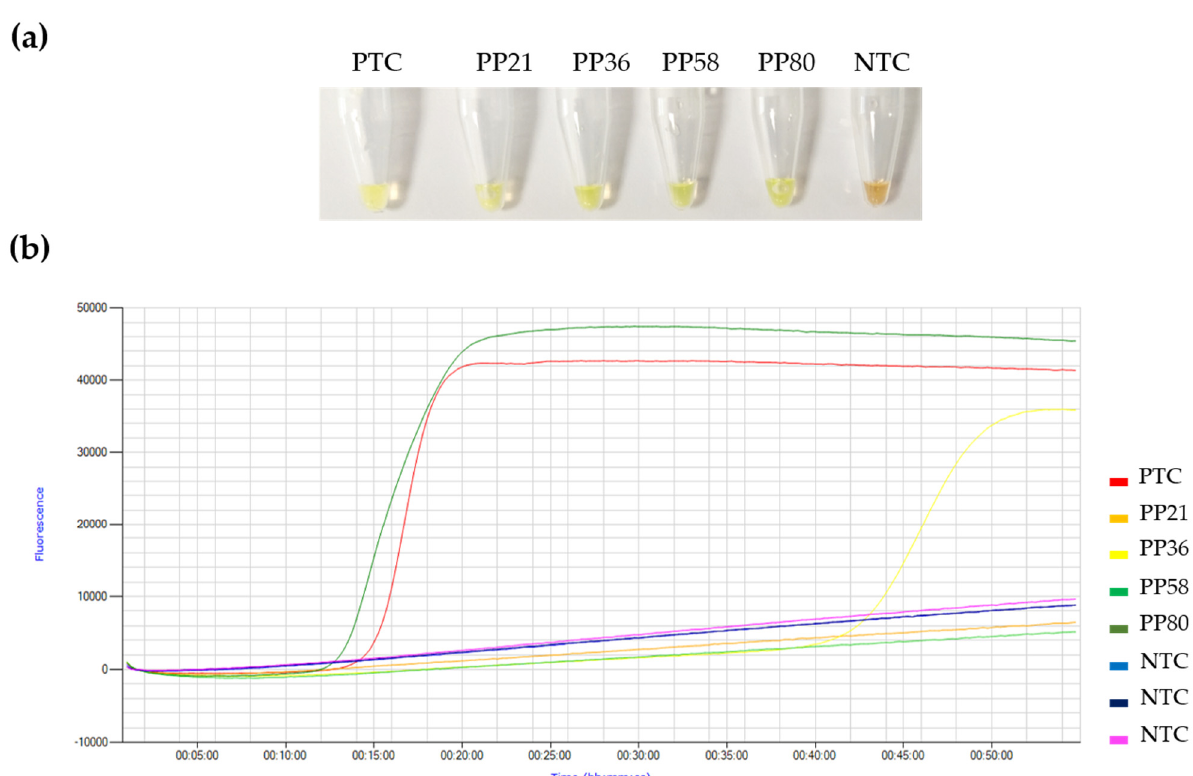
Figure 2. Detection of SARS-CoV-2 RNA in urine samples by colorimetric and real-time N15-RT-LAMP. ( a ) Colorimetric N15-RT-LAMP: results detected with SYBR Green I. Green/yellow, positive results; orange, negative results. ( b ) Real-time N15-RT-LAMP: results detected by fluorescence in a Genie III device. PTC, positive template control (2 µL of RNA purified from a nasopharyngeal swab from a patient with a RT-qPCR-positive result for SARS-CoV-2; Ct = 25 for ORF1ab); PP21, PP36, PP58, and PP80, patient urine samples; NTC, negative template control (2 µL of ultrapure water instead RNA).